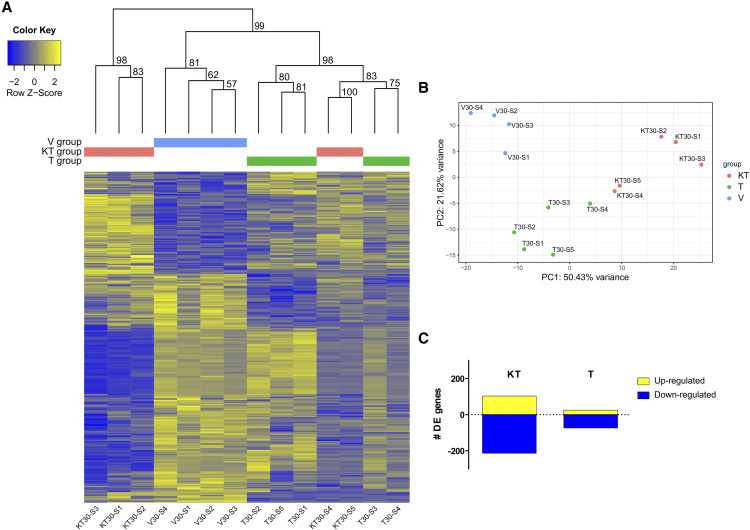
Differences in forebrain gene expression patterns of fish injected with vehicle (V-treated group), 11-ketotestosterone (KT-treated group) or testosterone (T-treated group) at 30 min post-injection: A. Heatmap of differentially expressed genes. Intensity of color indicates relative expression levels of each gene (rows) in each treatment (columns), with blue representing downregulated transcripts and yellow upregulated transcripts. For each cluster obtained with hierarchical clustering, unbiased p-values (value between 0 and 1 but here in %) can be seen above the heatmap. These values were calculated via multiscale bootstrap resampling, indicating how strong the cluster is supported by data. B. Principle Component Analysis (PCA) of DE genes of fish from the three treatment groups. C. Number of differentially expressed genes of fish injected with 11-ketotestosterone (KT-treated group) or testosterone (T-treated group) using a vehicle group (V-treated group) as a reference group.